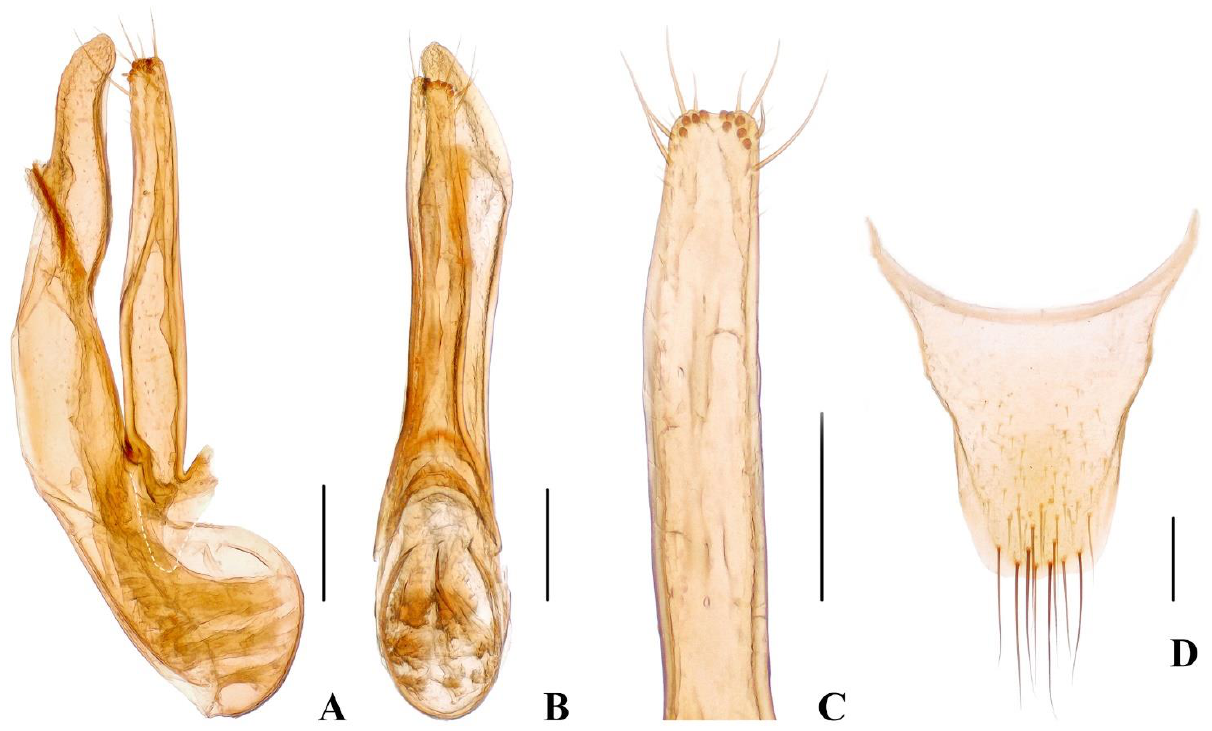
Figure 4. ( A – D ) Hesperoschema malaisei . ( A – C ) Aedeagus, lateral ( A ) and ventral ( B ) views; ( C ) paramere; ( D ) female abdominal tergite X. Scale bars = 0.2 mm.